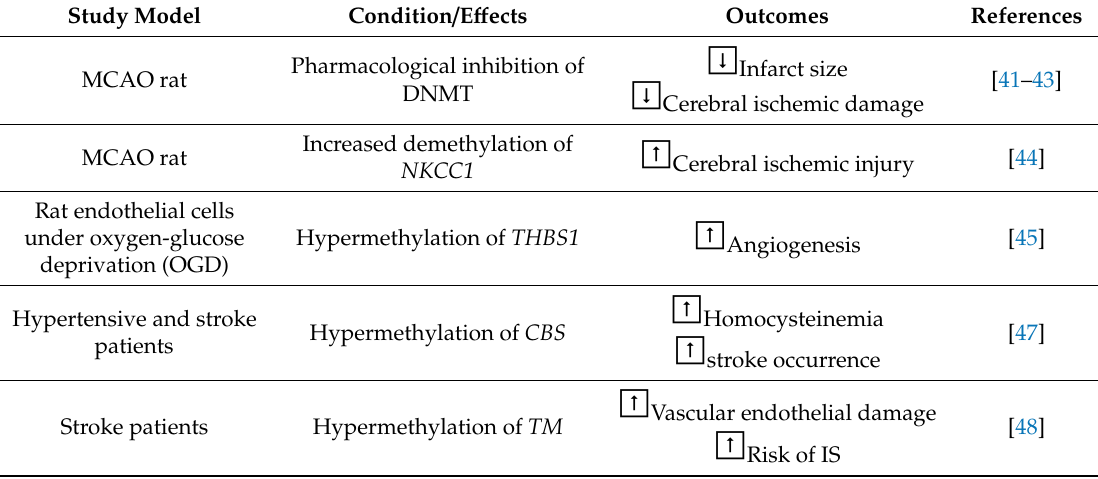
Table 1. DNA methylation in IS.